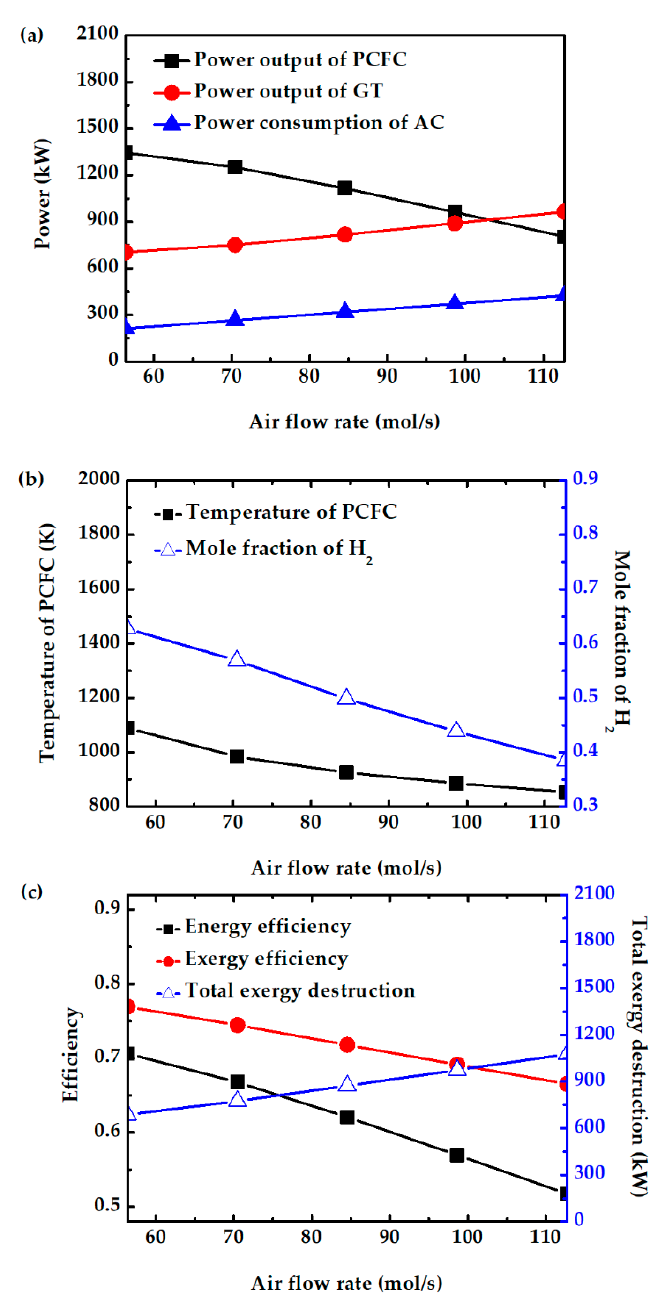
Figure 7. Effect of air flow rate on ( a ) power consumption of air compressor, power output of PCFC and GT, ( b ) PCFC operating temperature and mole fraction of H 2 , and ( c ) energy efficiency, exergy efficiency, and total exergy destruction.